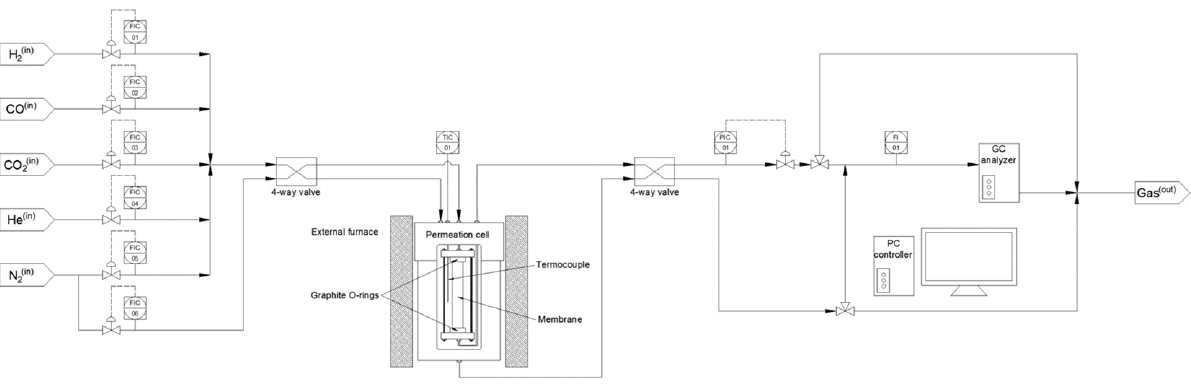
Figure 2. Schematic representation of the equipment used for permeation experiments at high tem ‐ peratures.